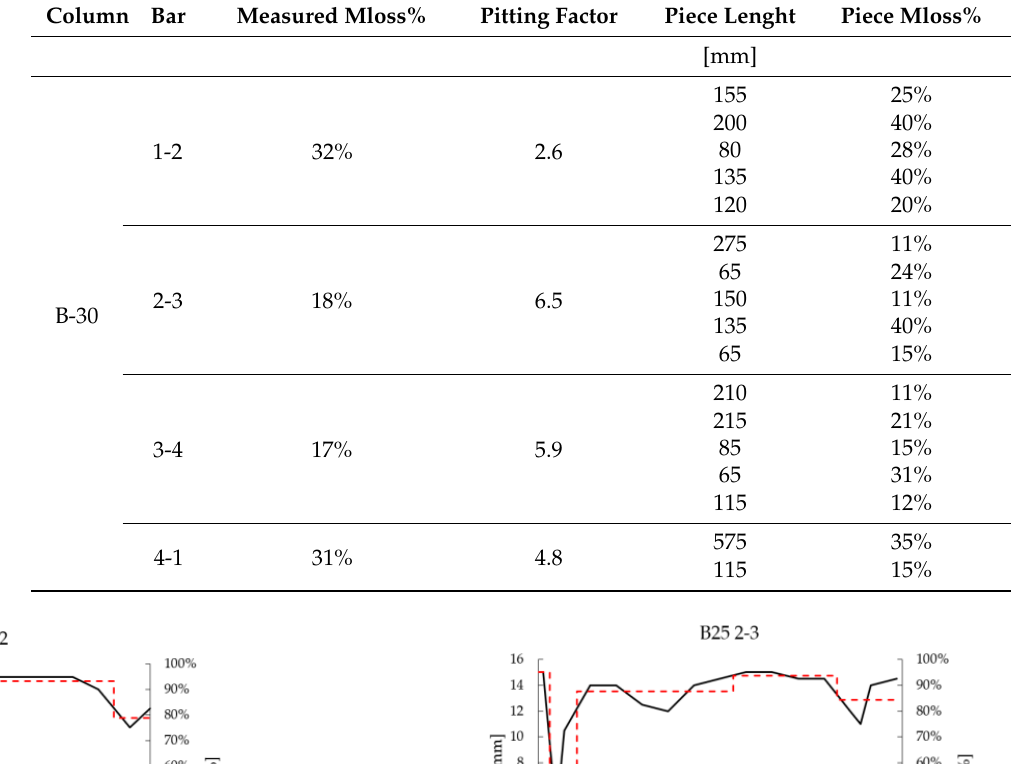
Table 6. Pitting factor and lost mass assumed for strategy 4, column B30.